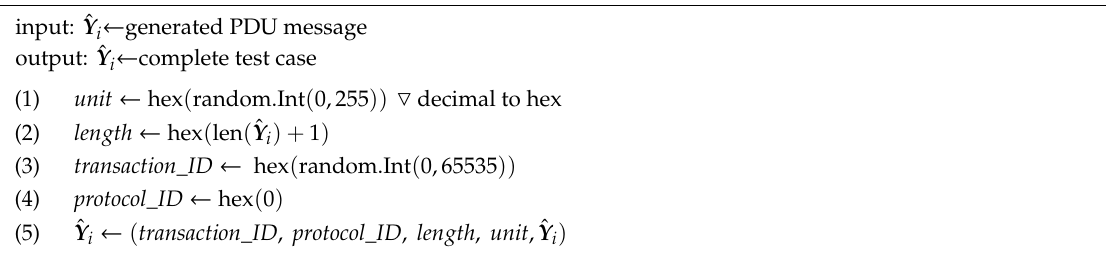
Algorithm 2: Complete Test Case Generation